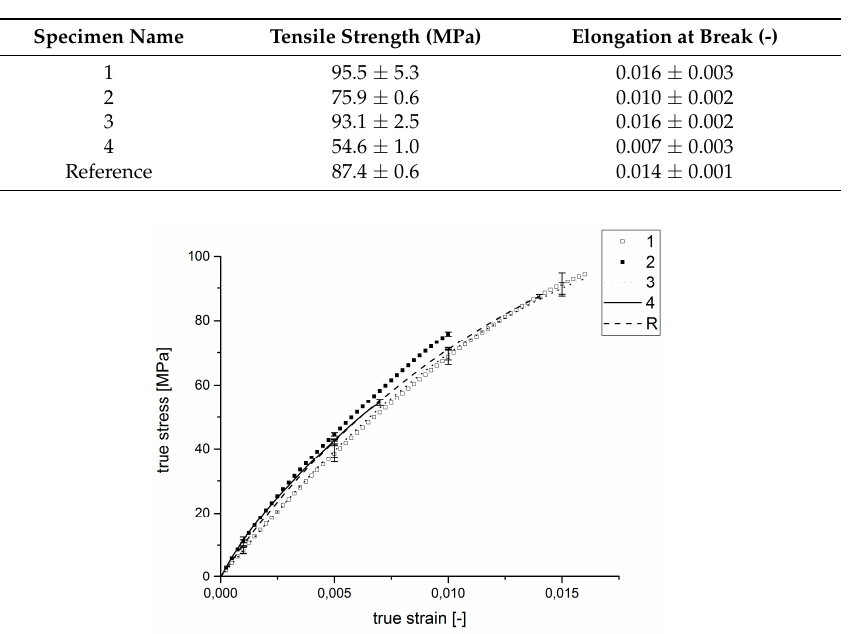
Table 15. Average tensile strength and elongation at break of the stress-strain behavior from the tensile tests for the samples influenced by the injection molding parameters.